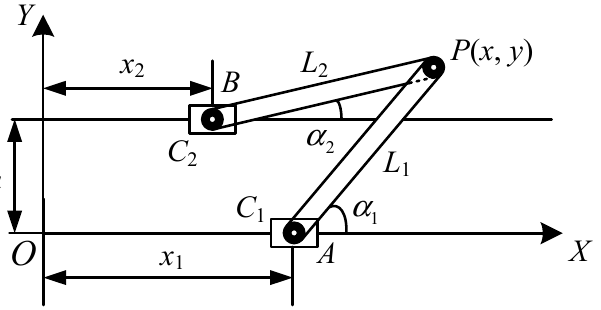
Figure 7. Structure diagram of lower limb rehabilitation training module.